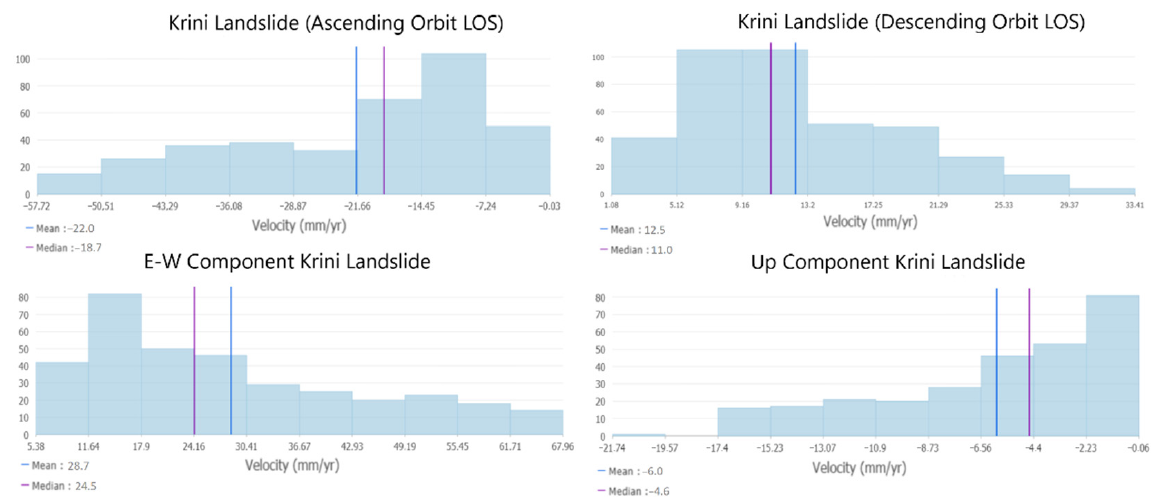
Figure 7. Histograms of LOS/E-W/U-D velocities of active landslides in the village of Krini (Affected area: 4,080,000 m 2 ).